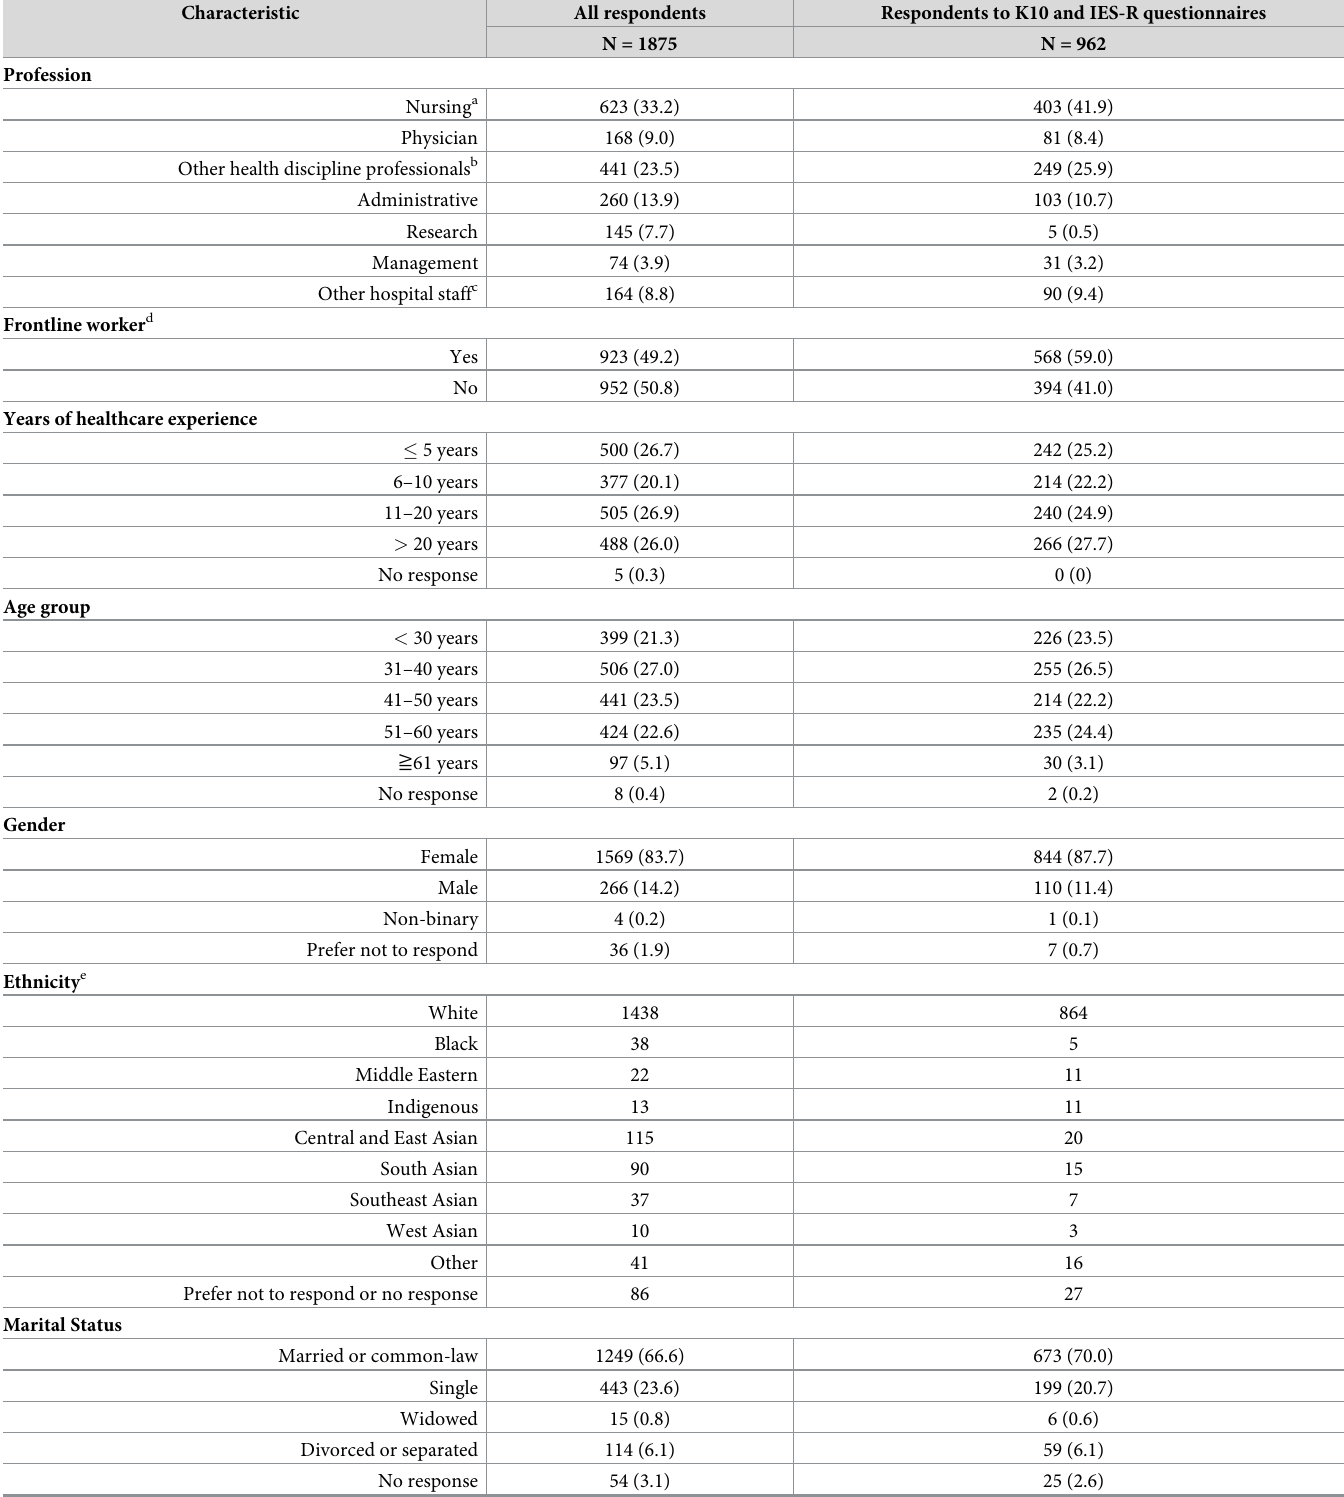
Table 1. Respondents’ professional and demographic